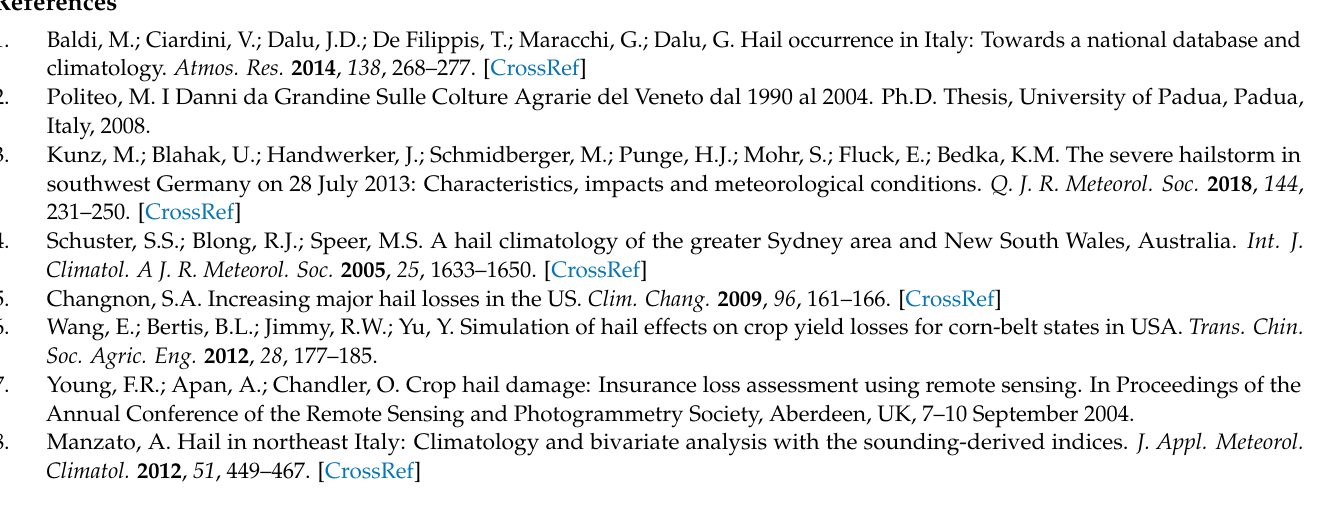
fields. Figure S1. SEBAL seasonal ET maps generated for Field 2 (a), Field 3 (b) and Field 4 (c). Figure S2. Relative error maps generated for Field 3 (a), Field 4 (b), Field 5 (c), and Field 6 (d) between measured and SEBAL-estimated yields. The following are available online at